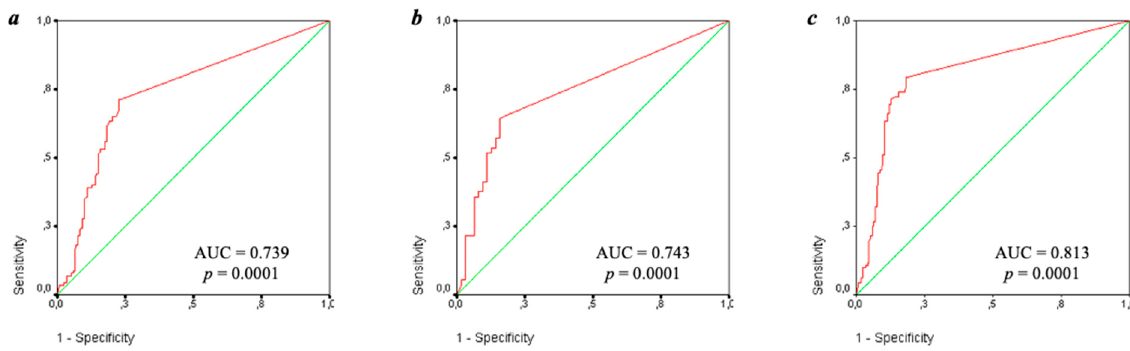
Figure 4. ROC-curves IgA anti- β 2 -GP1 depending on thrombosis ( a ), obstetric pathology ( b ), and reliable antiphospholipid syndrome ( c ). Note: AUC-area under curve and p -reliability.